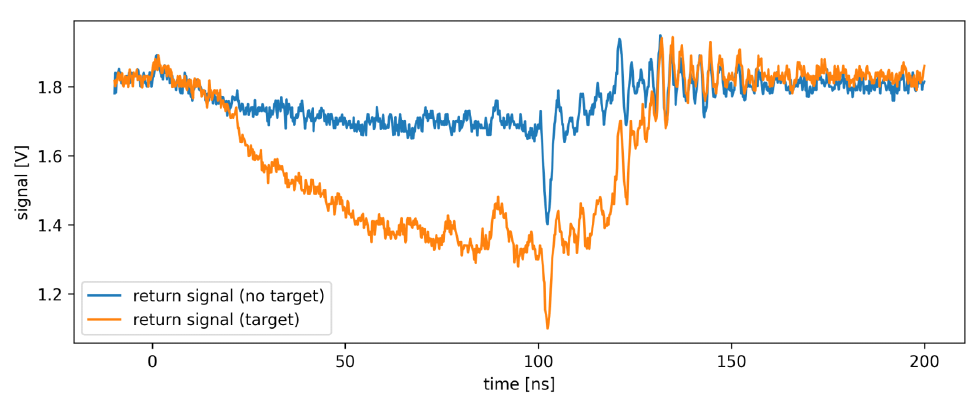
Figure 9. Shape of return signal for the configuration with a dusted protected silver first surface mirror. Return signal with no target in the detection range of the ranging device is shown in blue. Return signal with a poorly reflective target in sight is shown in orange. The root cause of the presence of the unwanted signal, and the consequent waveform’s changes are presented in the discussion section, where Figure 9 is referenced.